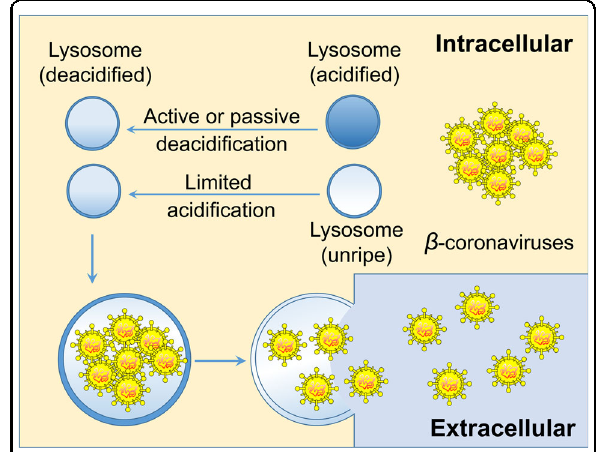
Fig. 1 Actively or passively deacidi fi ed lysosomes push β -coronavirus egress. Lysosomal deacidi fi cation may be caused by β -coronavirus infection, or the infected cells actively deacidify lysosomes to release newly generated β -coronaviruses for relieving their own viral